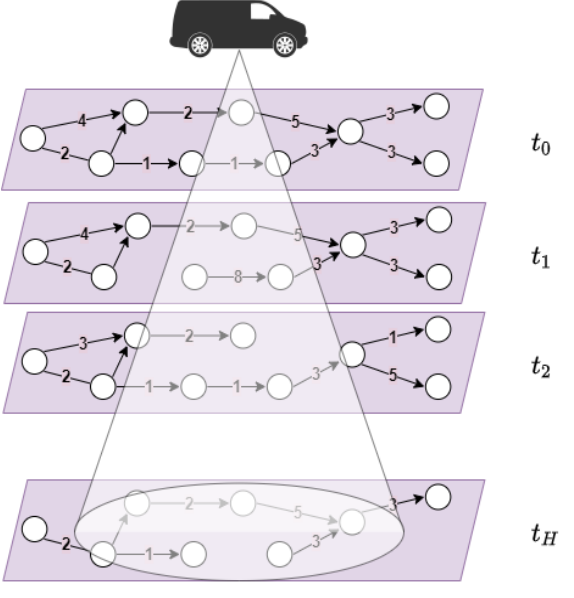
Figure 5. Initial spatio-temporal action